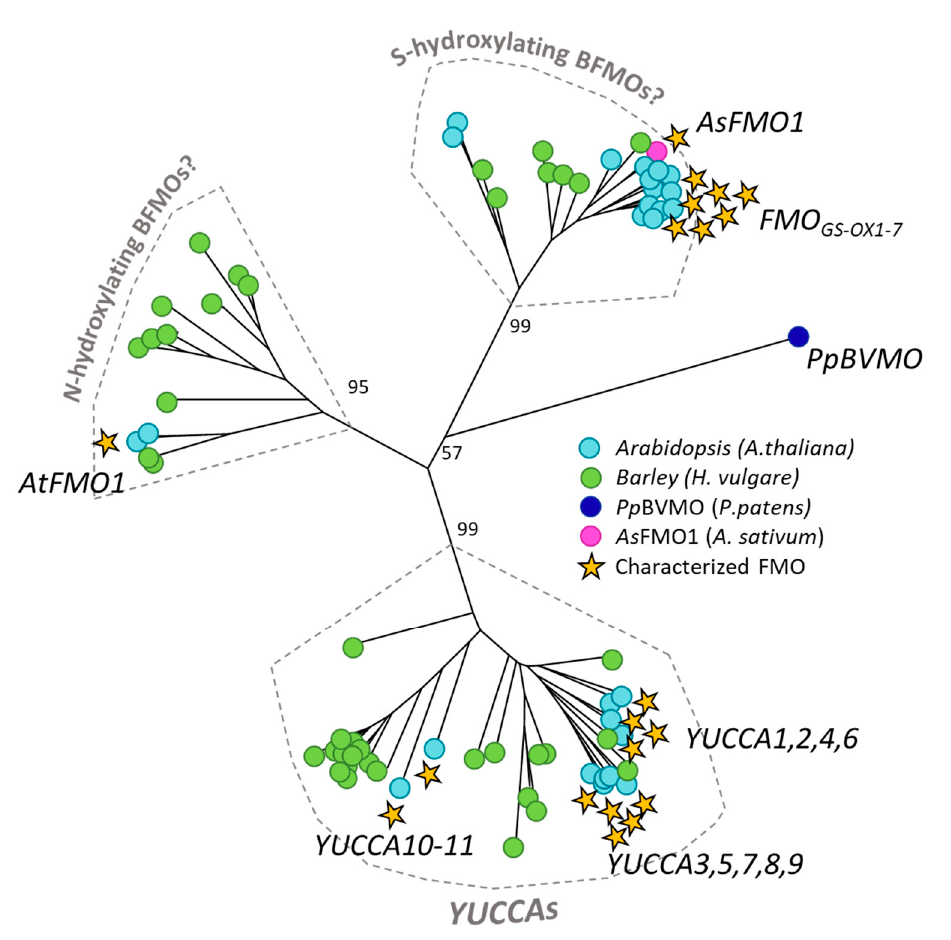
Figure 3. Phylogenetic tree of plant FMOs containing all predicted full-length BFMOs from Arabidopsis ( A. thaliana; cyan; total 29) and barley ( H. vulgare ; green; total 41, predicted from IPK Barley blast server). The tree also includes two additional characterized plant flavoproteins; the functionally characterized S-oxygenating FMO, As FMO1, from garlic ( A. sativum; pink) and the Pp BVMO from moss ( P. patens ; dark blue). All characterized proteins are marked with a star. Sequence analyses were conducted using MEGA 7.0. All amino acid sequences were manually inspected before being aligned using ClustalW. The phylogenetic relationship was inferred using the maximum likelihood method based on the JTT matrix-based model and n = 100 replicates for bootstrapping. The analysis involved a total of 74 amino acid sequences. The sequence IDs and resources employed in the phylogenetic analysis, and databases used to extract the sequence data, can be found in Supplementary Materials Data S2.